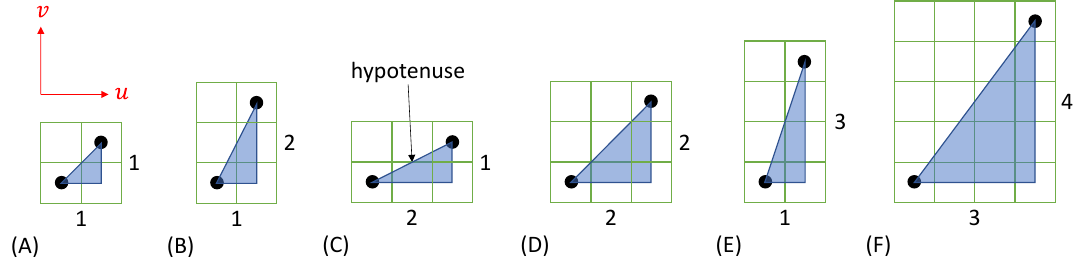
Figure 4. ( A – F ) Examples of different u – v rotation grids and their labelling.